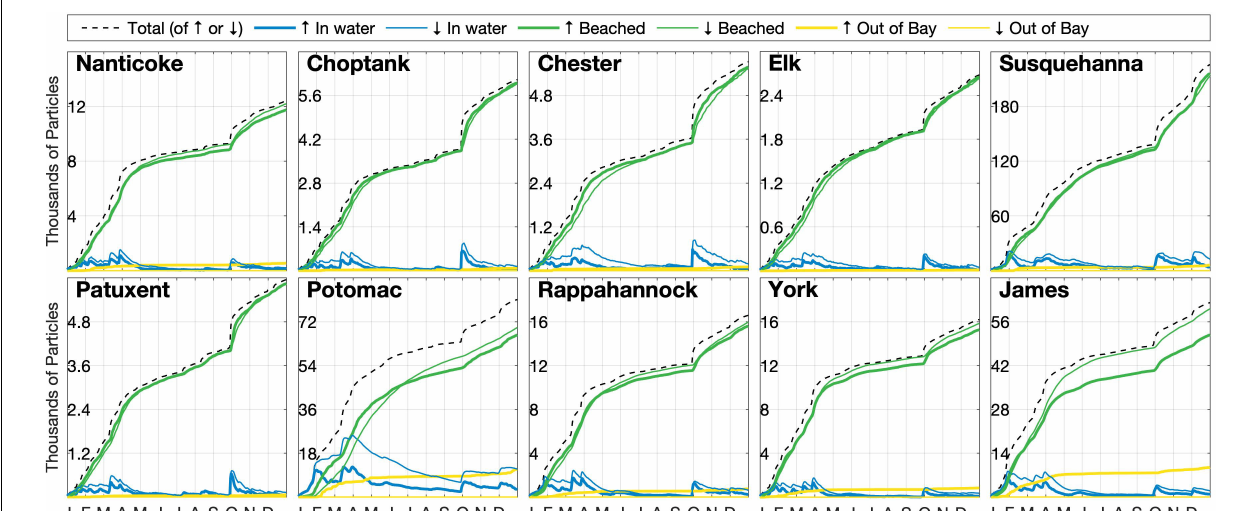
FIGURE 5 | The composite simulation time series of the individual inventories of particles (in water inside the Bay beached inside the Bay, or out of Bay) and their total by their river source location. Line thickness indicates whether the particles are less dense than seawater (thick) or denser than seawater (thin). The black line represents the sum of either all of the floating ( ↑ ) or sinking ( ↓ ) particles with time, as equal amounts were added throughout the simulation. Note difference in vertical